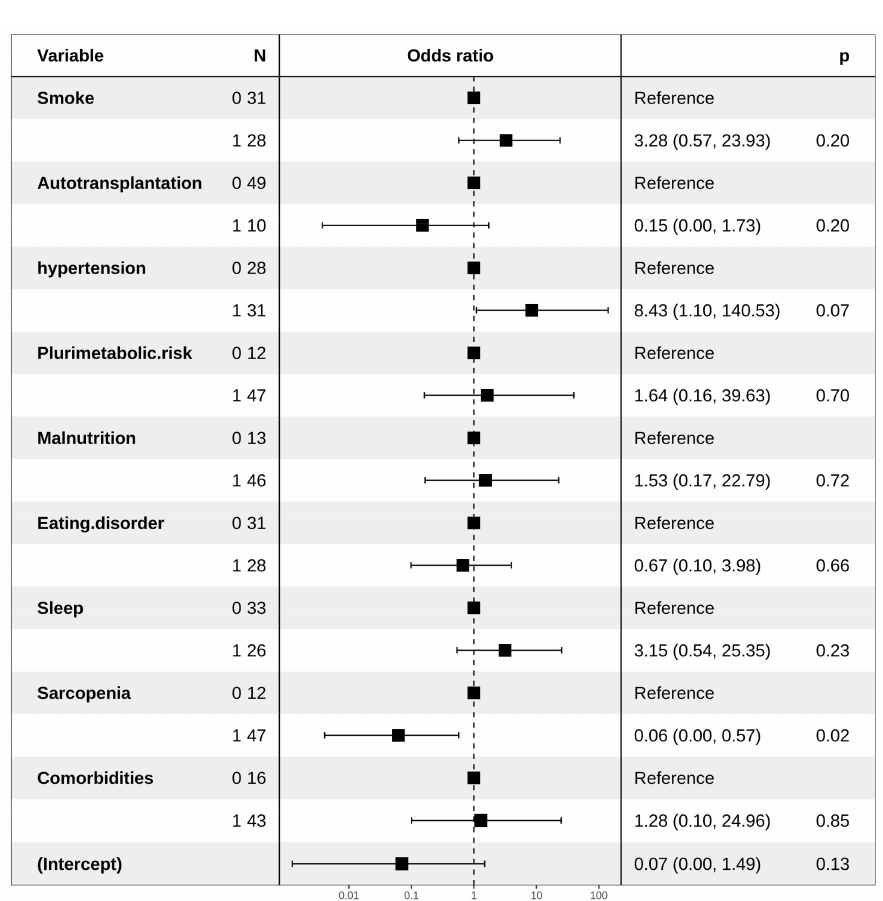
Figure 3. Forest plot representing multivariate logistic regression for dyslipidemia